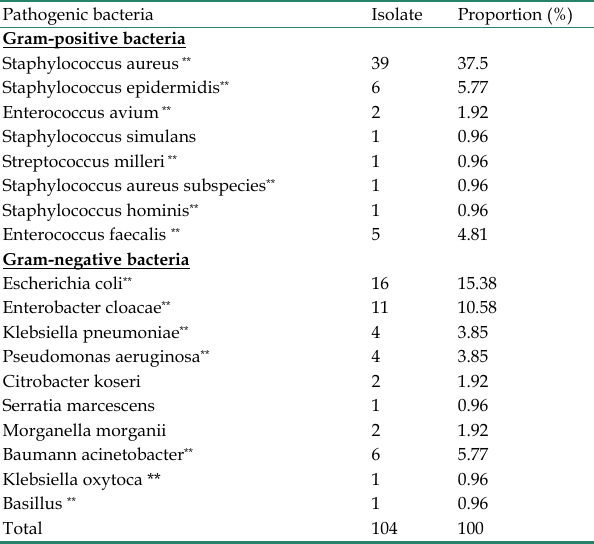
Table 3. The proportion and cases of the Gram-positive/negative bacteria Pathogenic bacteria